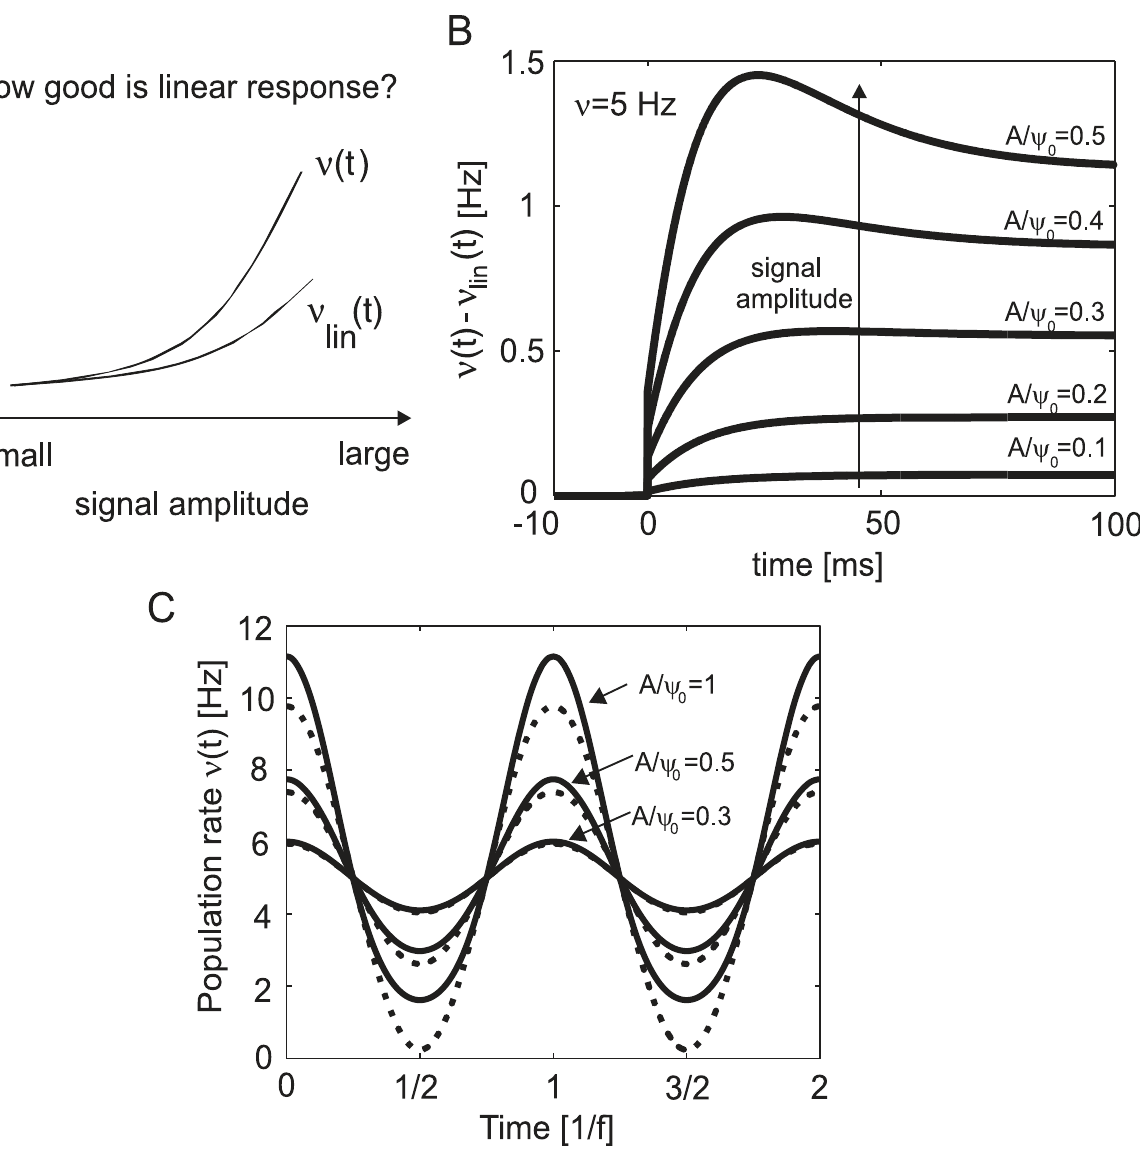
Figure 6. Fidelity of the linear approximation in relation to the complete non-linear response. (A) Schematic illustration of how well the linear approximation of the population rate derived for low amplitudes (as in Eqs. 25,26) captures the complete response dynamics. (B) Differences in linear and non-linear population firing rate in response to mean current steps of different amplitudes. Here, the linear response corresponds to Eq. 25 and the non-linear response derives from Eq. 20; stationary firing rate 5Hz and t s ~ 10ms . (C) Differences between the complete population firing rate (solid line, Eq. 20) and its linear approximation (dashed line, Eq. 21) in response to periodic mean modulations of 3Hz of different amplitudes. For an illustration of how the population dynamics n ( t ) emerges in response to a dynamic stimulus see Fig.